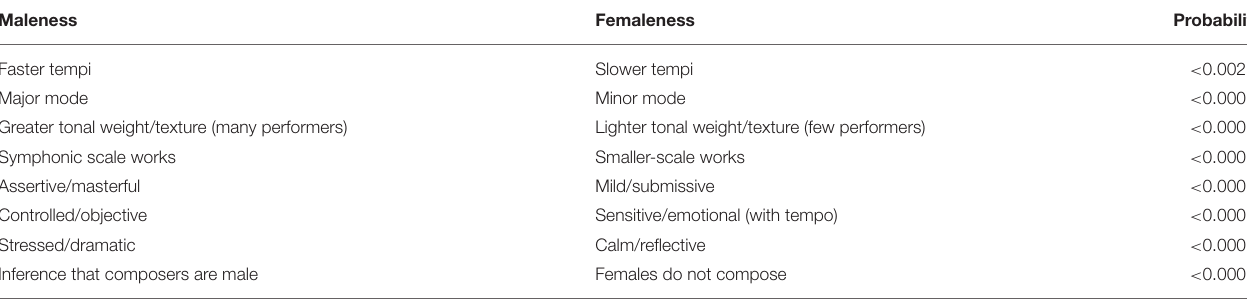
TABLE 4 | Properties influencing attributions of compositions to male or female composers.